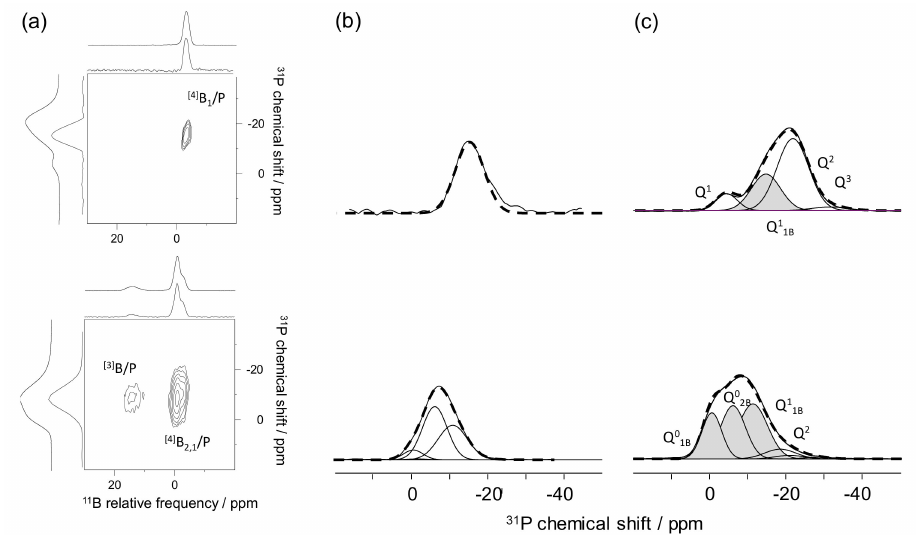
Figure 9. ( a ) 11 B / 31 P 2D maps obtained on lithium borophosphate glasses with low (top) and high (bottom) B 2 O 3 content at 18.8 T with the D-HMQC NMR sequence, ( b ) 31 P projections of the 2D map showing the phosphate attached to borate and ( c ) 1D 31 P–MAS-NMR spectra accompanied by the decompositions supported by the 2D NMR data [22]. Adapted with permission from